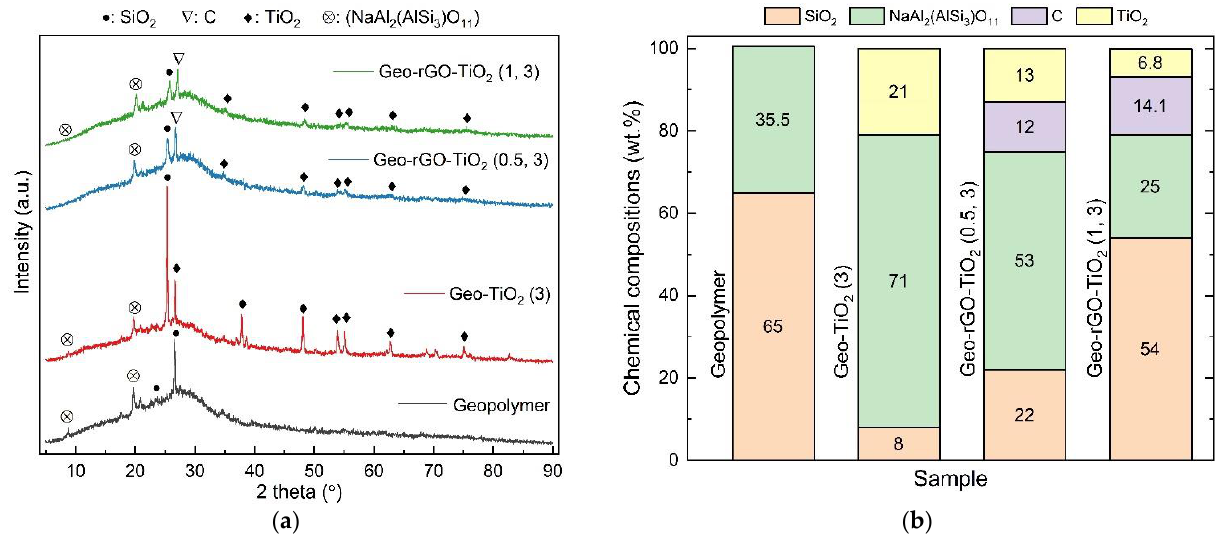
Figure 9. ( a ) Diffractogram, and ( b ) the distribution of chemical compositions of the membranes: Geopolymer, Geo–TiO 2 (3), Geo–rGO–TiO 2 (0.5, 3), Geo–rGO–TiO 2 (1, 3). The addition of rGO and TiO 2 did not change the amorphous nature of geopolymer.